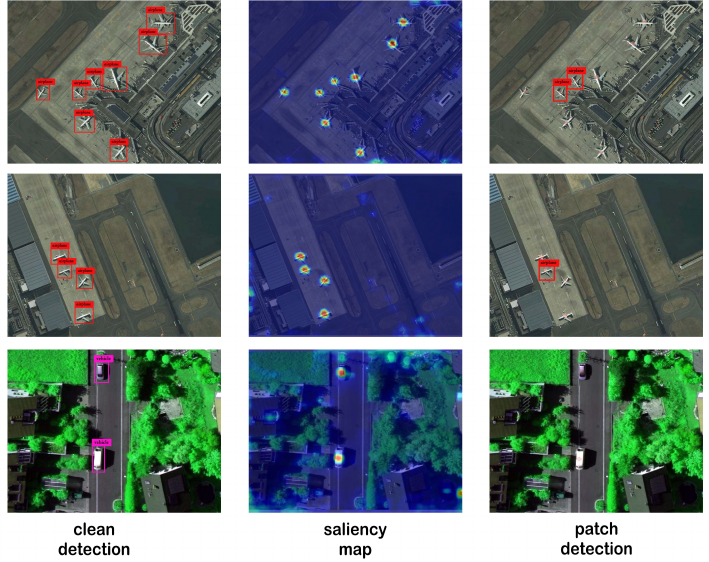
Figure 6. Some adversarial perturbation examples of remote sensing images.The first column in the figure represents the detection results of the clean examples, the second column represents the saliency map used to generate the mask, and the third column represents the detection results of the adversarial examples after the